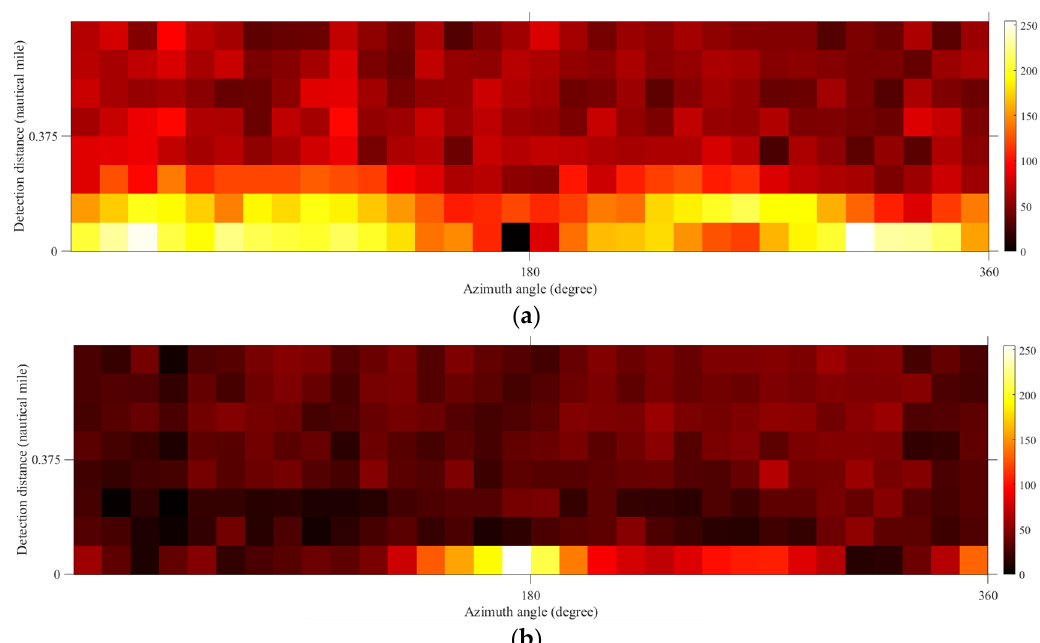
Figure 7. The visualizations of PC1 and PC2: ( a ) PC1; ( b ) PC2.